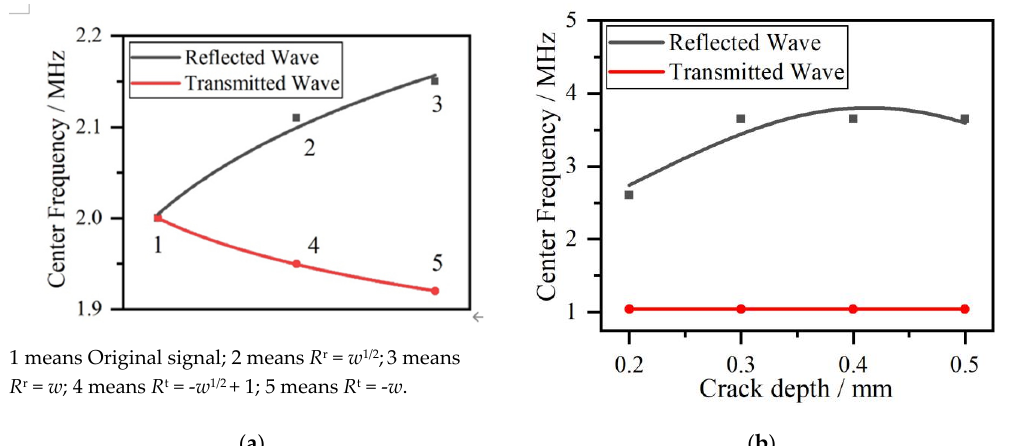
Figure 7. ( a ) The results based on Gaussian function. ( b ) The results based on the FEM.